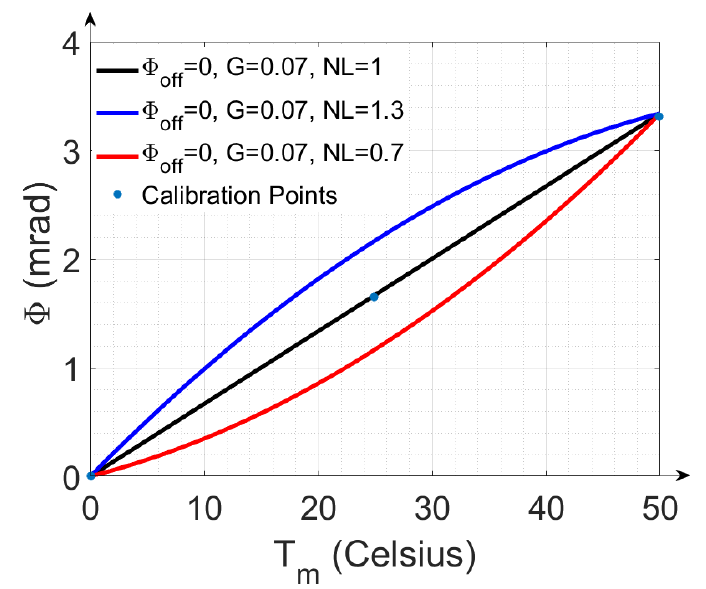
Figure 5. Graphical representation of cubic spline interpolation with three reference points over a temperature range of 𝑇 𝑟𝑒𝑓𝑚𝑖𝑛 = 0 °C to 𝑇 𝑟𝑒𝑓𝑚𝑎𝑥 = 50.0 °C. Three cases are displayed. When NL = 1, a linear relationship is obtained (black line). Any variation of NL away from 1 generates a non-linear relationship (blue and red line).